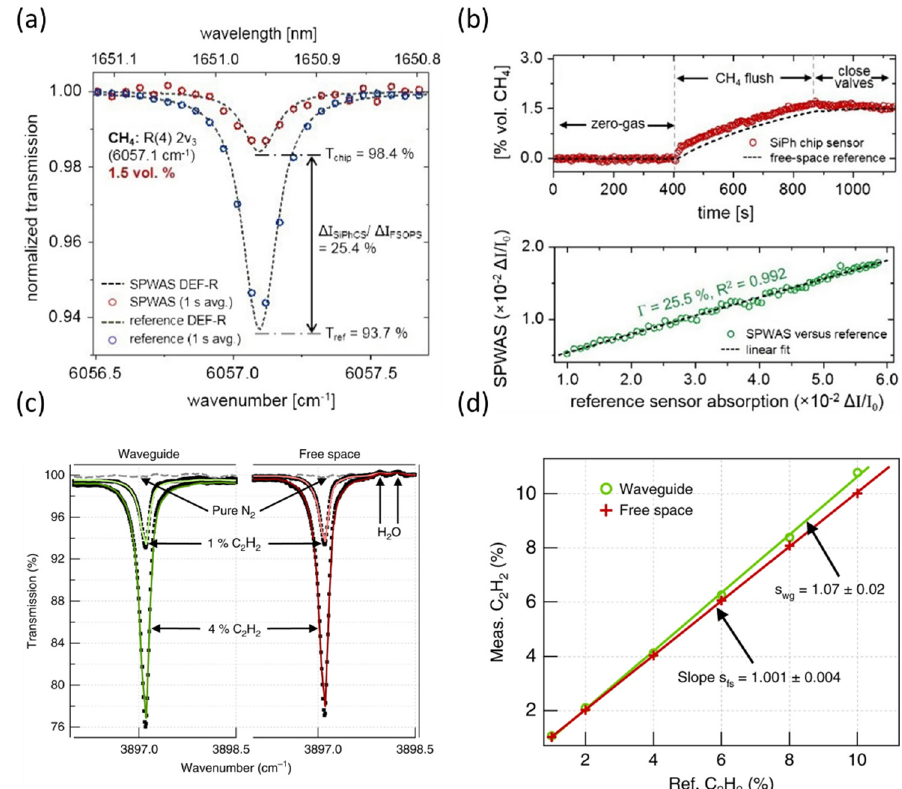
Figure 3. Experimental demonstration of gas detection by WIRAS. ( a ) The spectrum of the methane R(4)2 ν 3 line measured by the waveguide-based integrated spectrometer design by Zhang et al. [157]. The Voight spectral fit for 1.5% methane concentration is shown in red, together with the experimental data. ( b ) Upper plot: experimentally measured methane concentration before and after flushing the chamber with methane. Lower plot: correlation between the absorption measured with the waveguide device and a free-space reference beam, indicating Γ = 25.5% in the waveguide (reproduced with permission from reference [157]). ( c ) Comparison of experimental absorption spectra for 4% and 1% acetylene measured using a free-standing tantala waveguide and a free space beam of identical path length, reproduced from Vlk et al. [69]. ( d ) Correlation of the measured concentration to the reference concentration of data in ( c ). The slope gives Γ = 107% (reproduced with permission under a Creative Commons Attribution 4.0 International License.